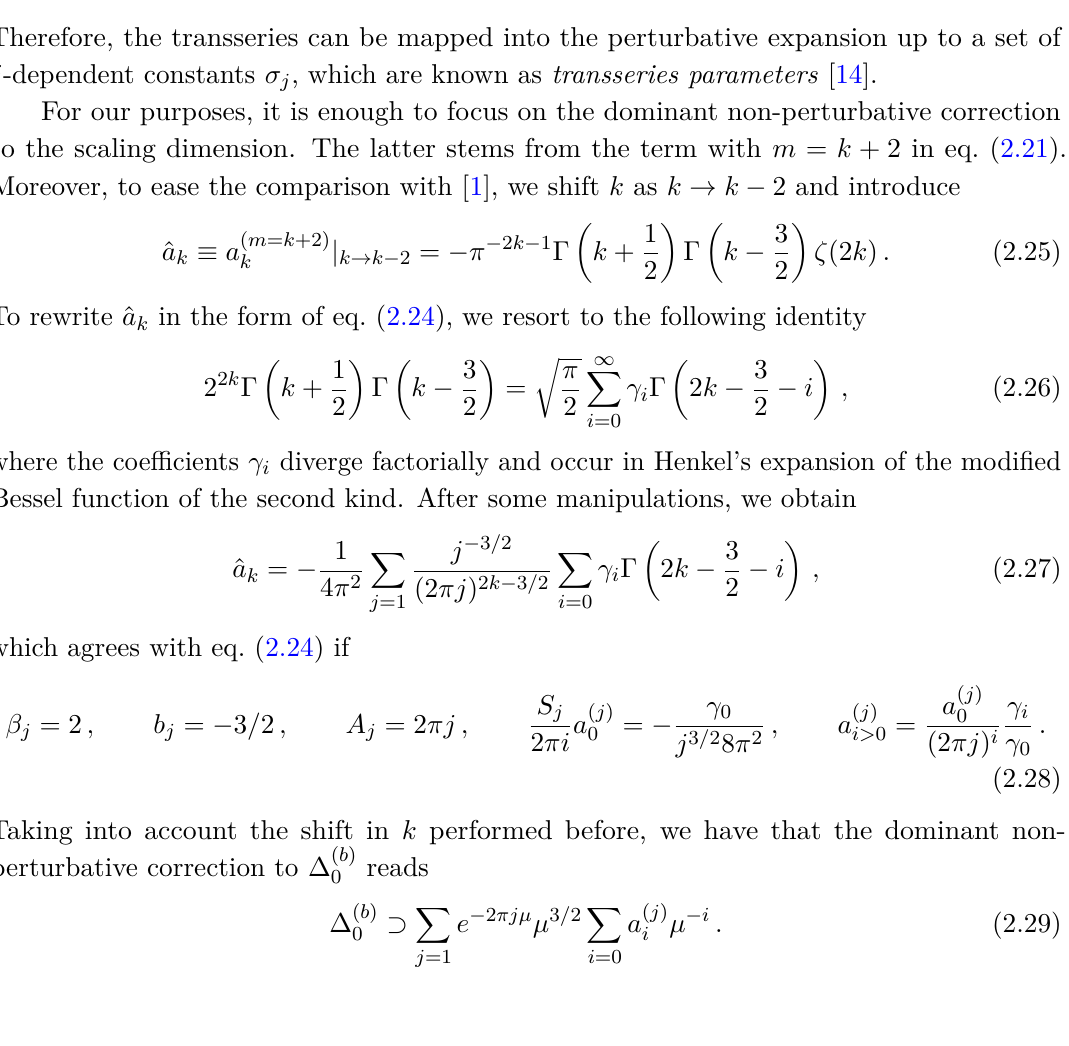
(with a given by eq. (2.21)) for growing k . The k k 2 a k = 0 . 101321 . . . π 2